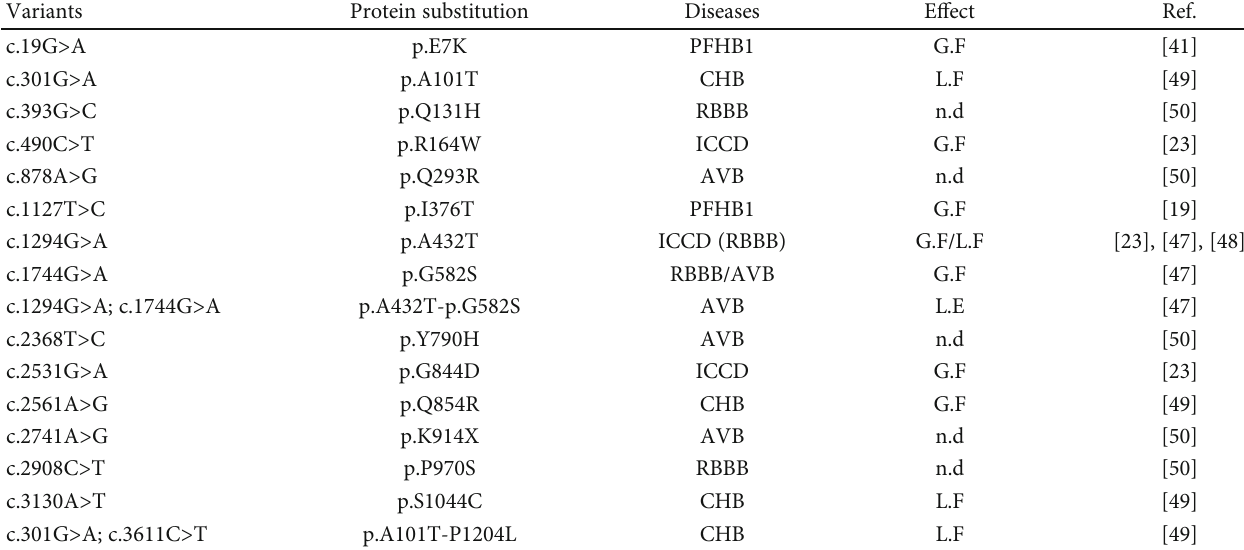
Table 1: List of genetic variants of TRPM4 found in patients displaying cardiac conduction